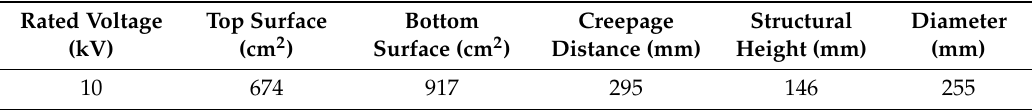
Table 1. Parameters of the XP-70